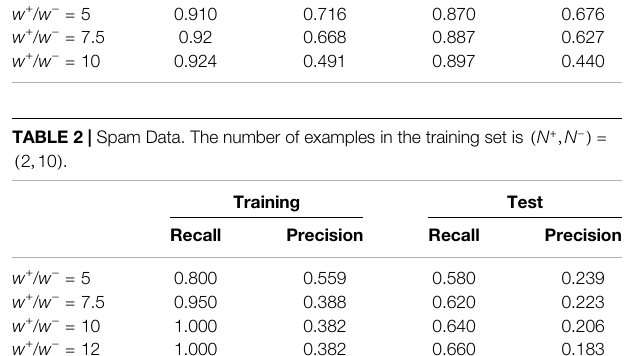
TABLE 1 | Spam Data. The number of examples in the training set is ( N + , N − ) (cid:2) ( 200 , 2000 ) . Training Test Recall Precision